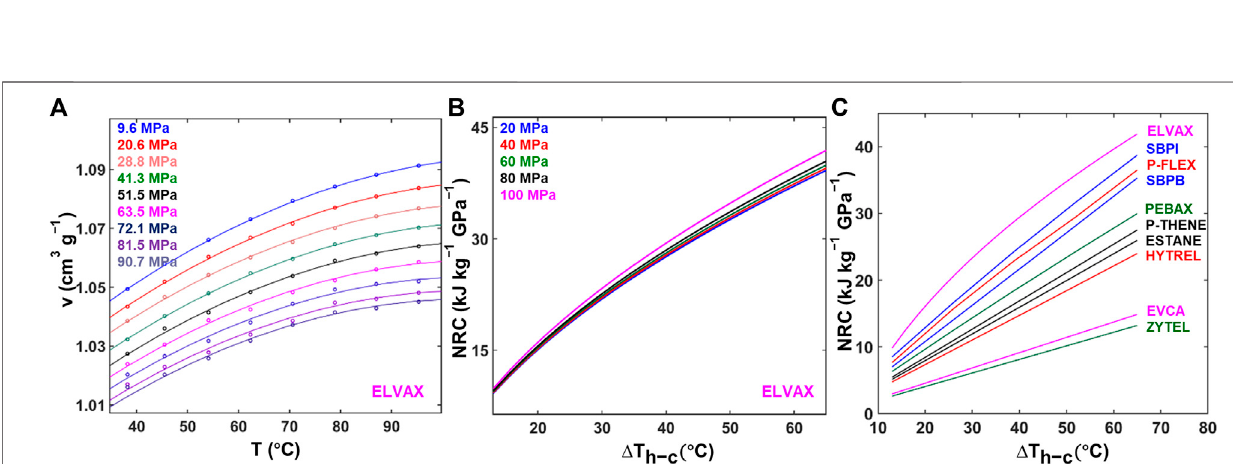
Frontiers in Energy Research |